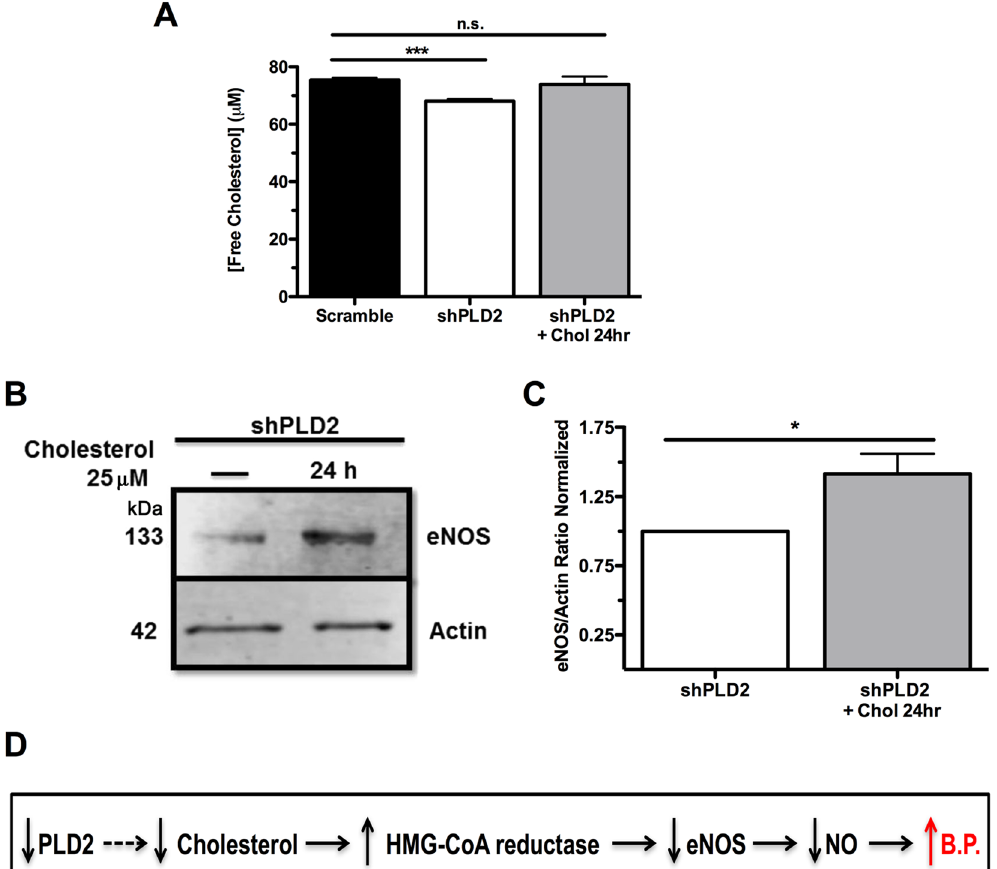
Figure 6. Recovery of eNOS levels in shPLD2 cells following exogenous cholesterol supplementation. ( A ) Free cholesterol levels monitored by cholesterol oxidase assay after culture of cells with 25 μ M exogenous cholesterol (in media) for 24 hours (n = 4). ( B ) Representative western blot of eNOS protein in shPLD2 cells with and without cholesterol supplementation. The regions of the Western blots (Suppl. Figure 3) containing the eNOS and actin immunoreactive bands were scanned and the relative abundance of the individual samples quantified using an Odyssey CLx imaging system. ( C ) Quantification of western blot with eNOS levels normalized to actin (n = 5). ( D ) Schematic summary of model. Dotted line indicates that the mechanism involved is unknown at this time. Mean ± SEM; * p < 0.05; ** p ≤ 0.001; C, Student’s t-test; A, one-way ANOVA with Bonferroni’s Multiple Comparison